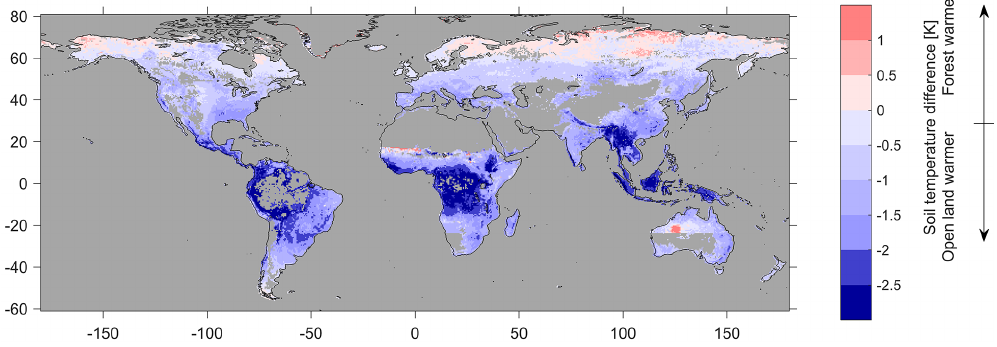
Figure A3. Difference in vertically averaged annual mean soil temperature of forest minus open land in CLM-BASE. Table A5. Area-weighted annual mean ET for each PFT analyzed in this study according to the GETA data and in the different configurations of CLM4.5 and fraction of the land surface covered by the different PFTs. The global integral of annual ET is listed on the bottom. Abbr.